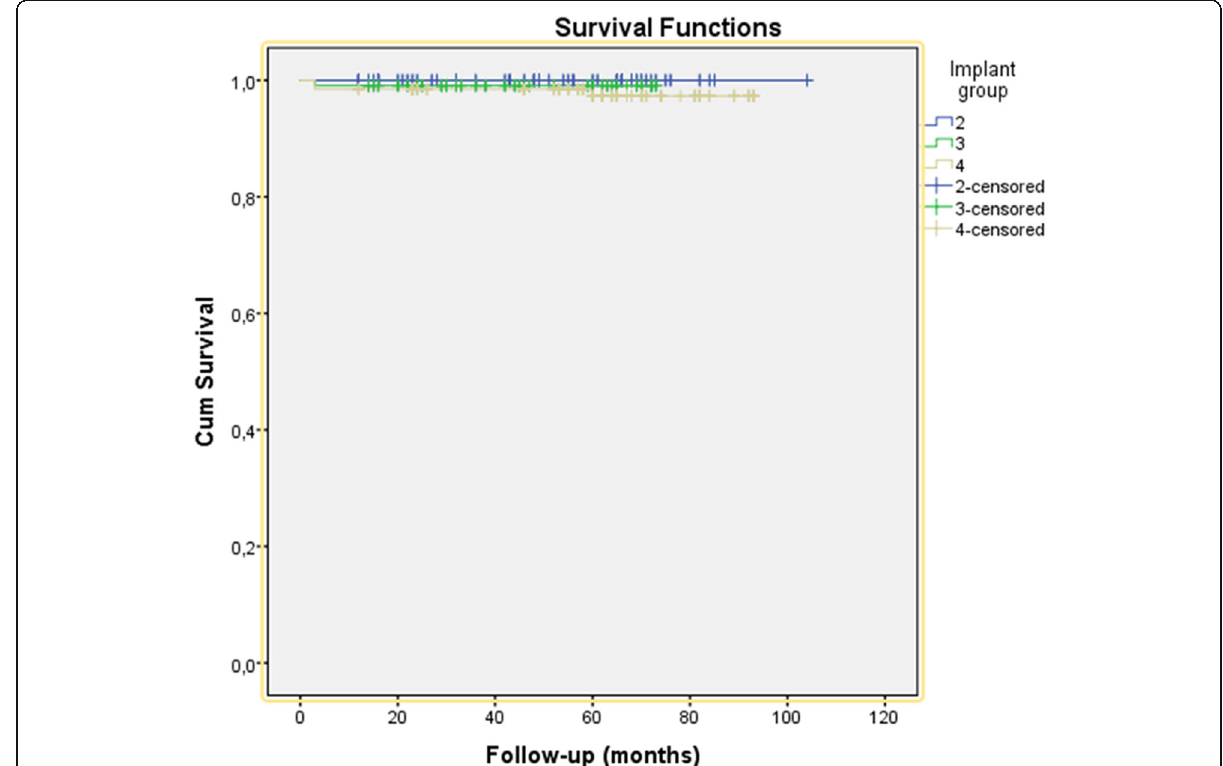
Fig. 1 Cumulative survival rate of 2-implant group, 3-implant group, and 4-implant